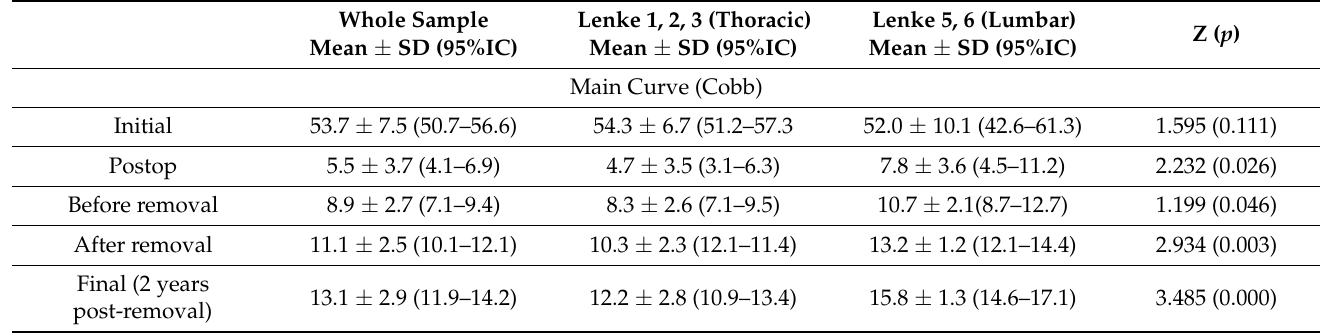
Table 3. Evolution of coronal and sagittal plane of the main curve along the different stages of